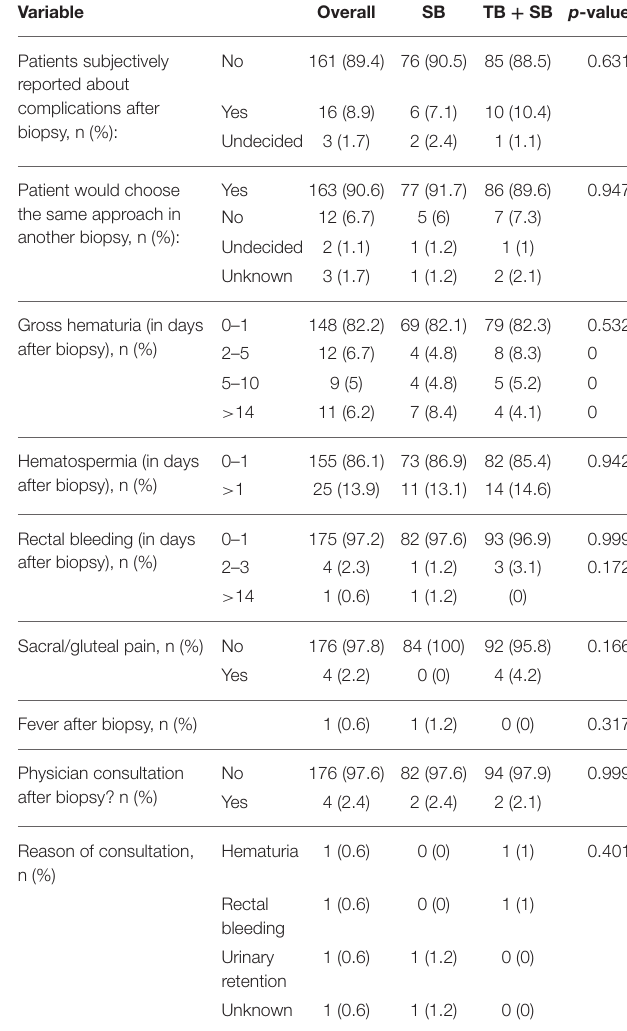
TABLE 2 | Complications after transrectal prostate biopsy of patients between 01/2018 and 05/2019 stratified for SB and SB + TB. Variable Overall